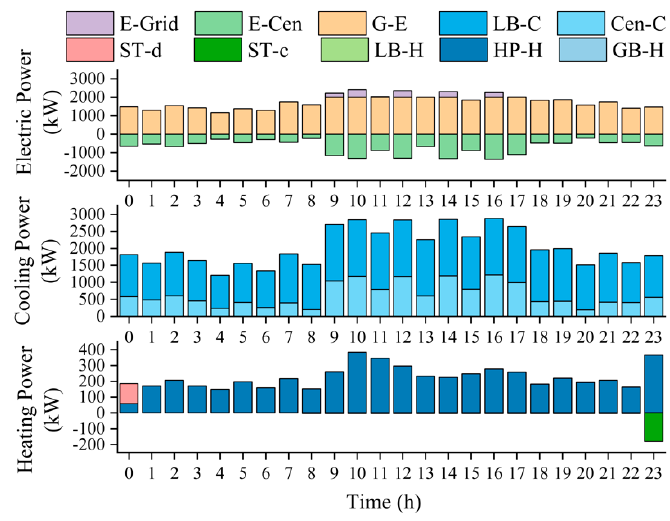
Figure 11. The output of operator’ equipment in case3 in summer.